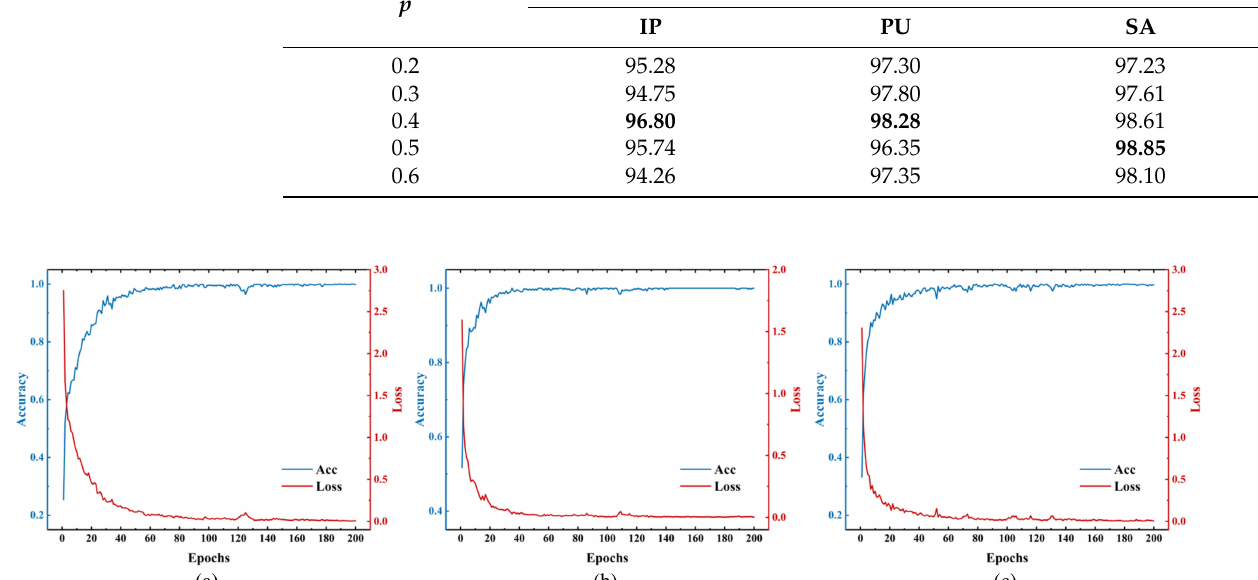
Figure 11. Accuracy and loss graphs of the three datasets: ( a ) IP; ( b ) PU; ( c )